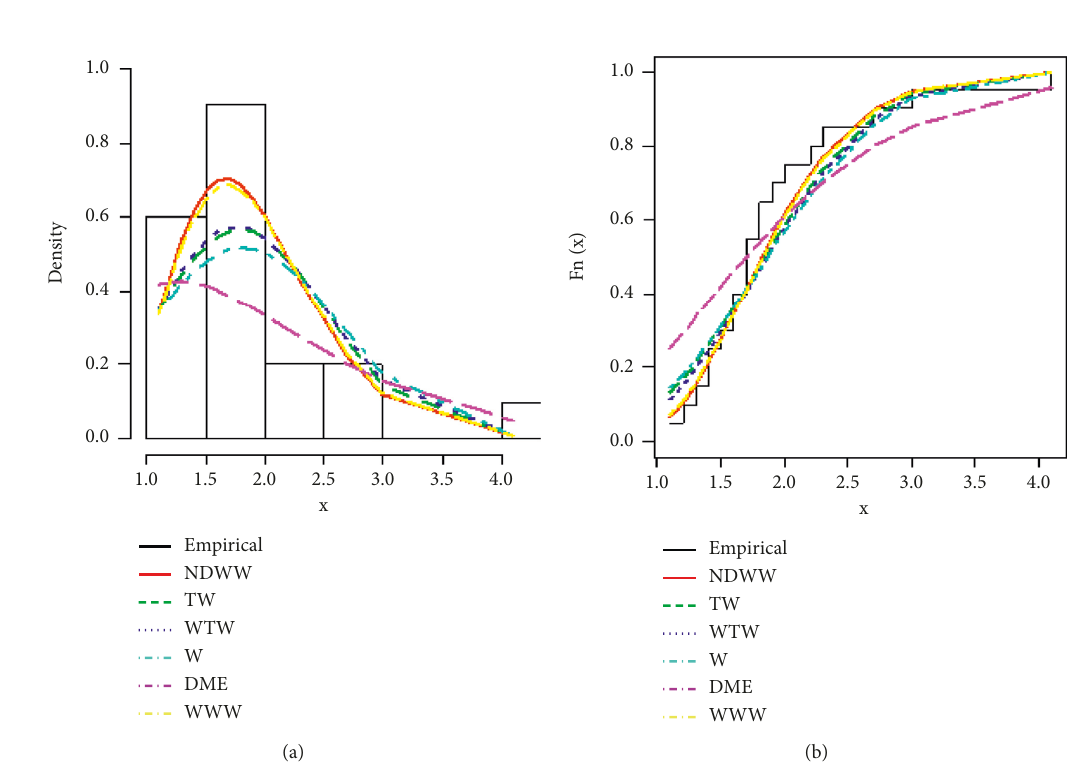
Figure 4: The fitted pdfs (a) and cdfs (b) for the dataset (2).